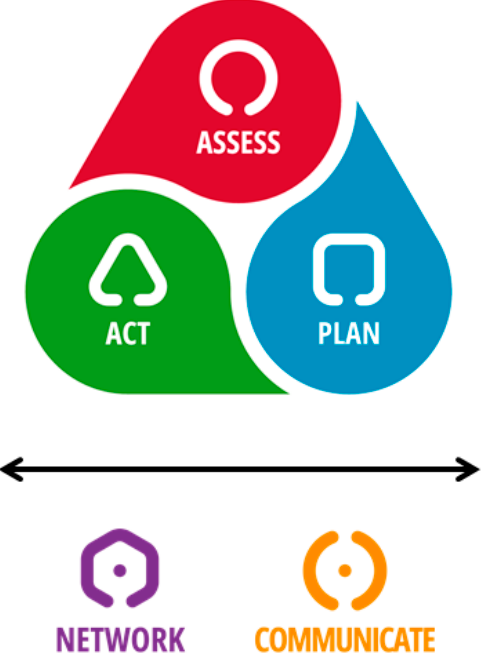
Figure 2. The Species Conservation Cycle has three components that follow each other—Assess, Plan and Act—and two more that are transversal to all—Network and Communicate.